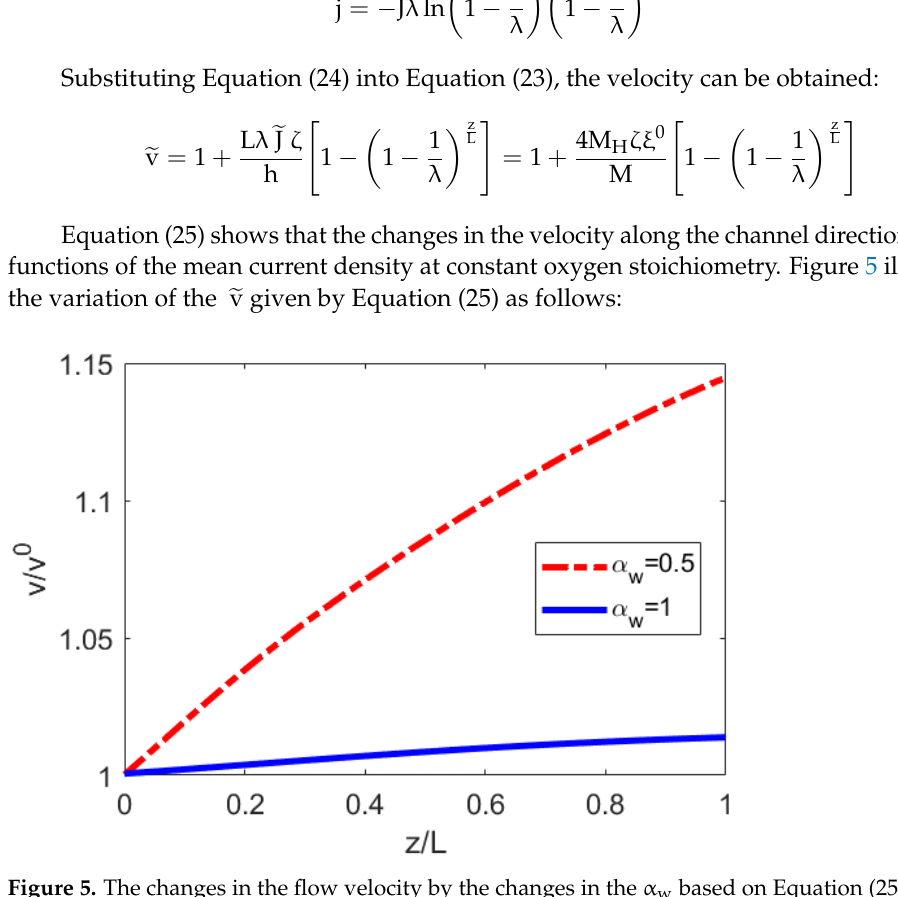
Figure 5. The changes in the flow velocity by the changes in the α w based on Equation (25).